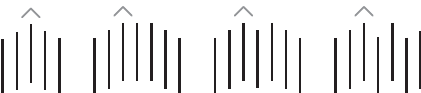
Fig. 1. A few examples of up-trend fractal